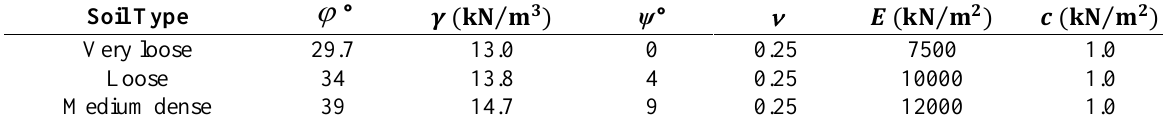
Table 1. Parameters of different soils considered in numerical